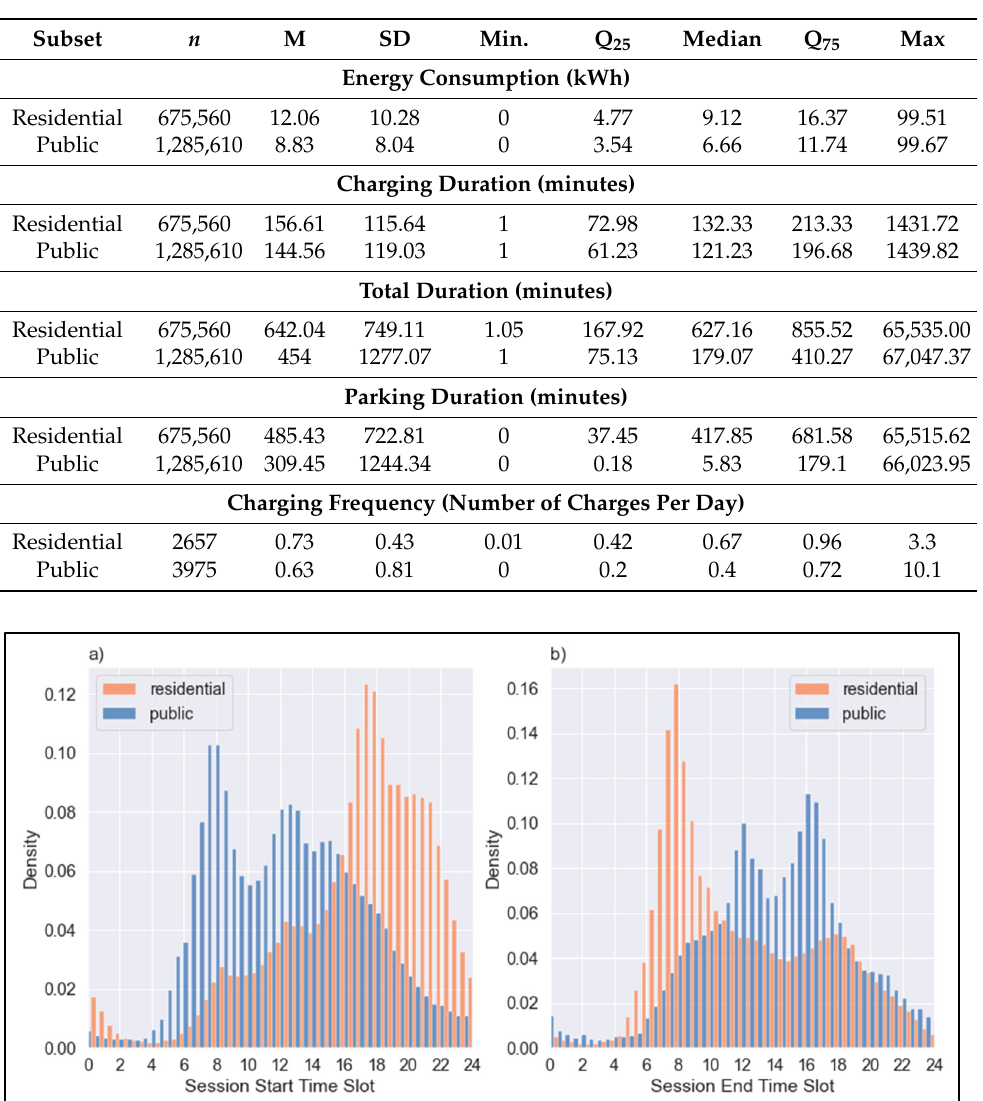
Table 2. Summary statistics of utilization variables for residential and public Level 2 charging stations.